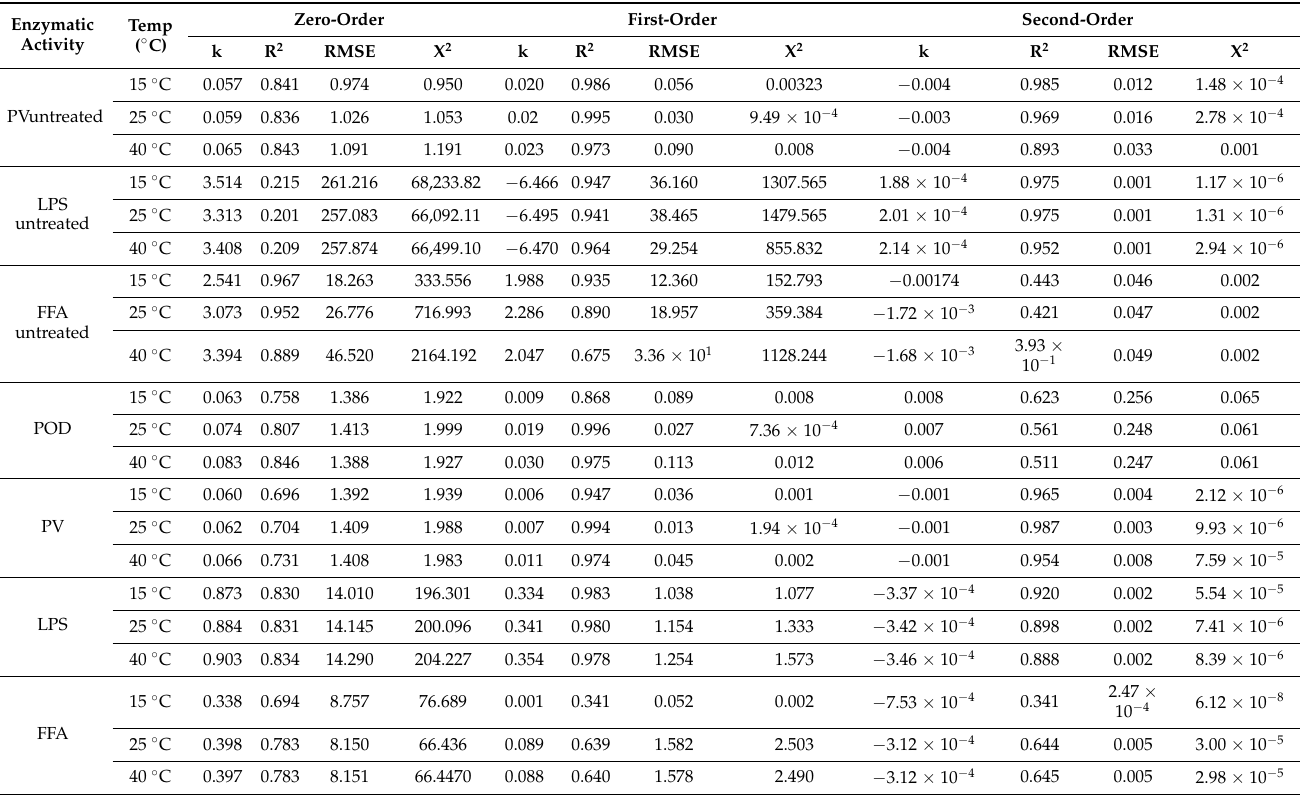
Table 7. Linear regression analysis for the Arrhenius plot of rice bran enzymatic activity and fatty acids at varied storage